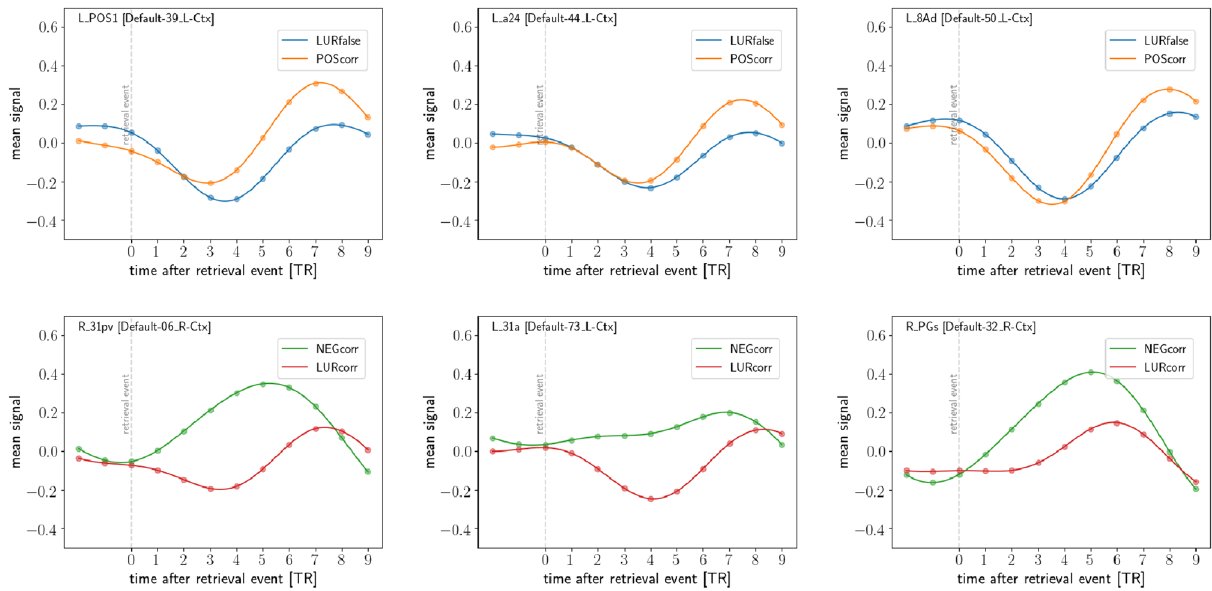
Figure 4. Selected regions with maxima in the period 5–9 TR after POScorr–LURfalse (top) and NEGcorr– LURcorr (bottom)